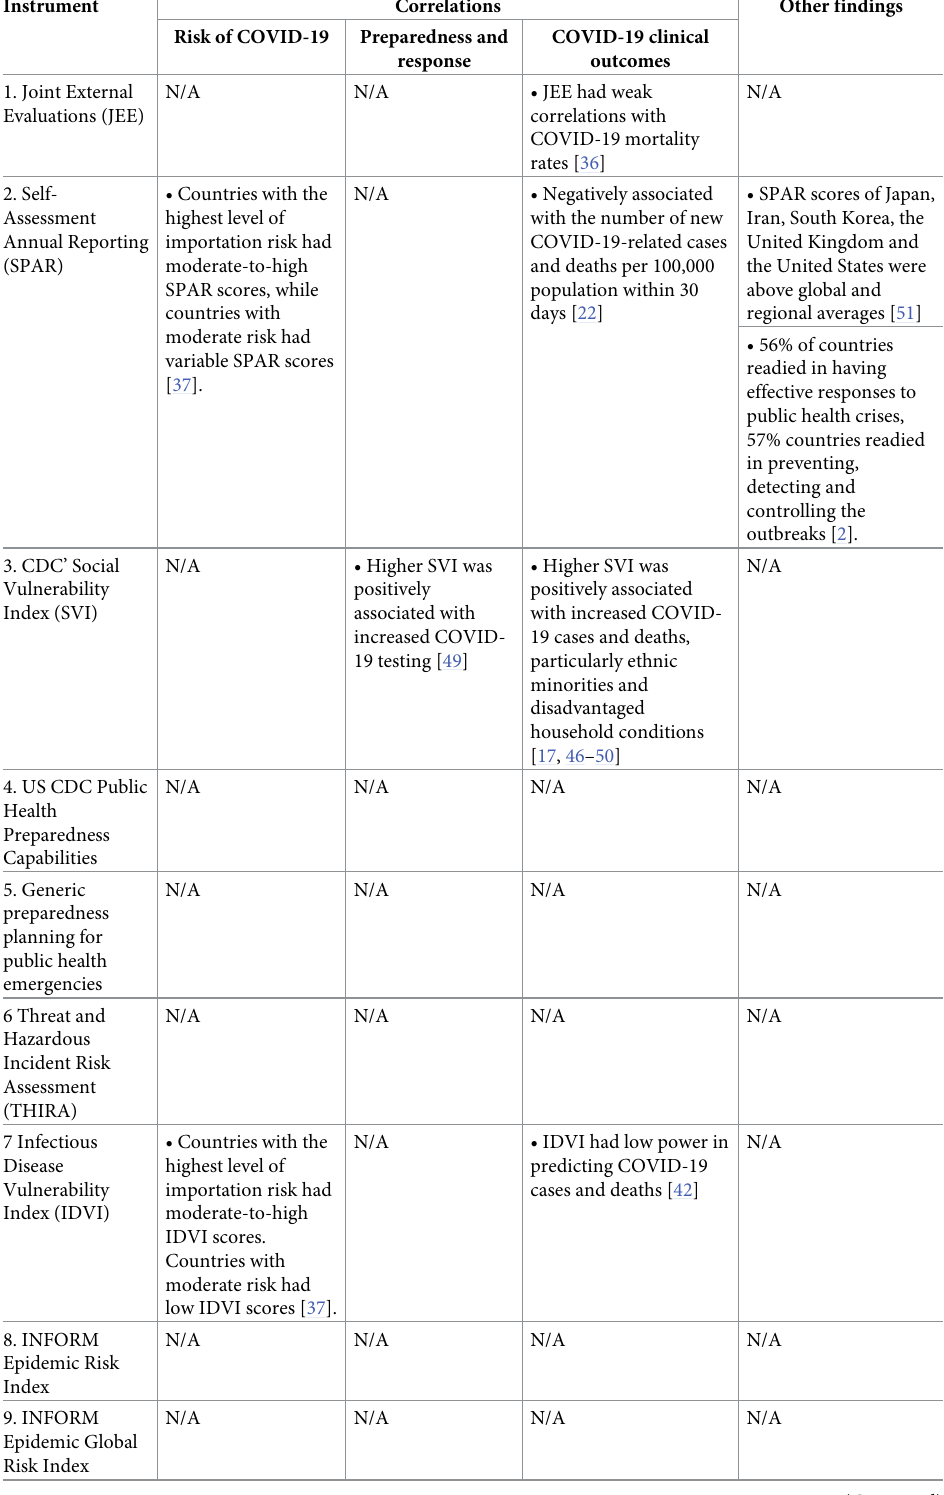
Table 6. Application of selected instruments in COVID-19 risk